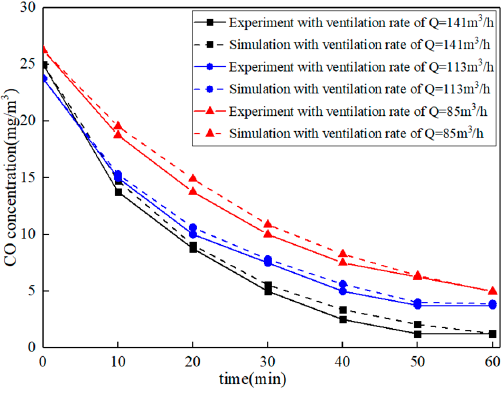
Figure 10. Model reliability verification.